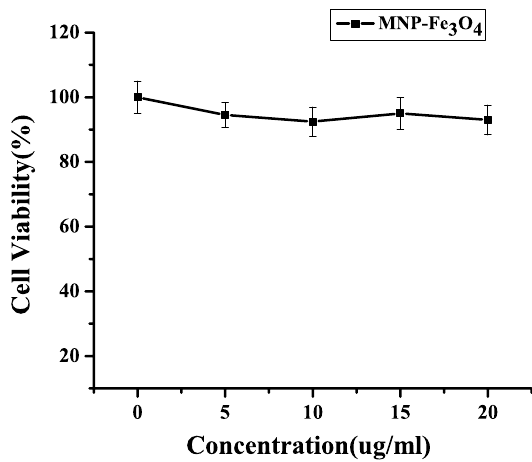
Fig. 3. Observation of MNP – Fe 3 O 4 internalized HepG2 cells using MTT.